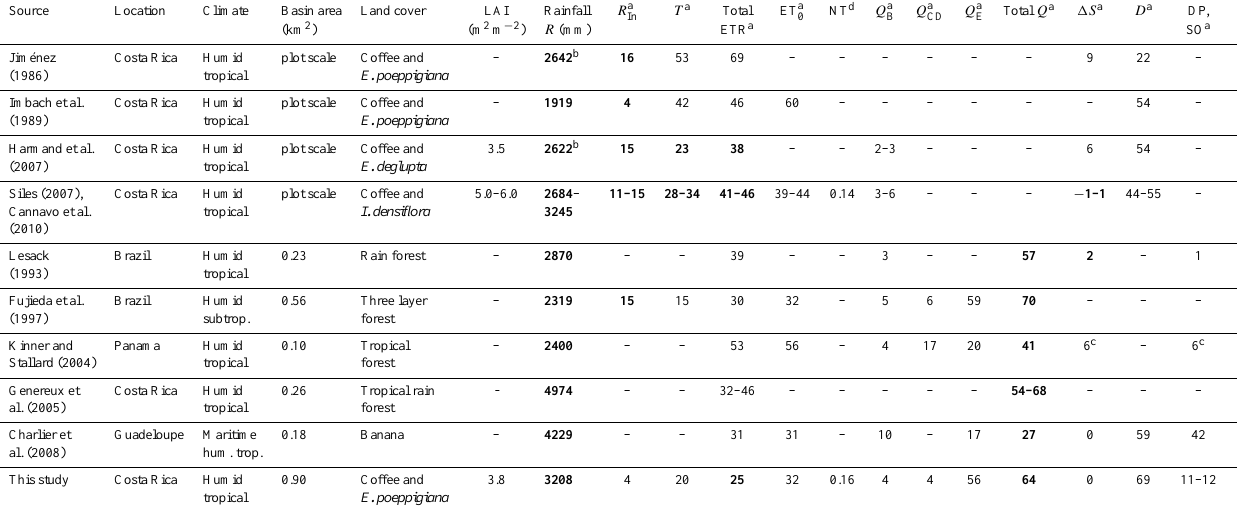
Table 4. Comparison of annual water balance components (as % of rainfall) for different studies at plot and basin scales, in tropical regions. Source